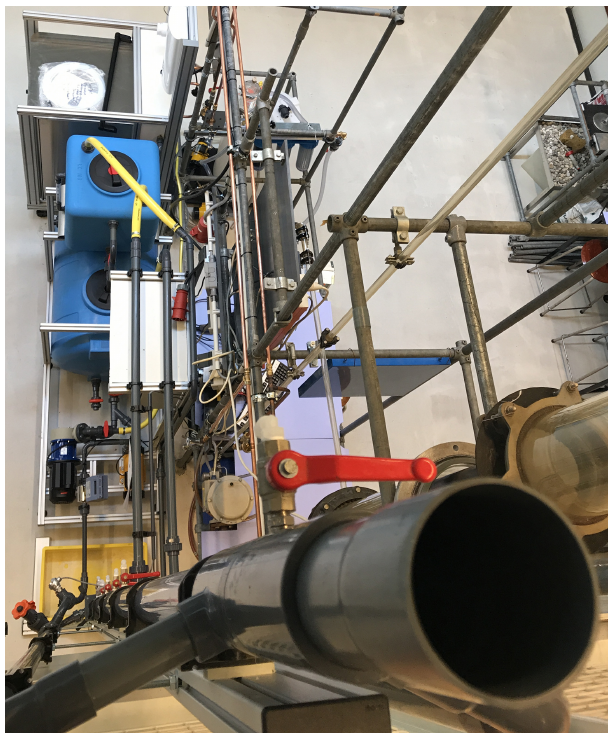
Figure 1. Experimental pilot set-up in Amsterdam, Utrecht, and London. D = 57mm, with temperature control column (top view).